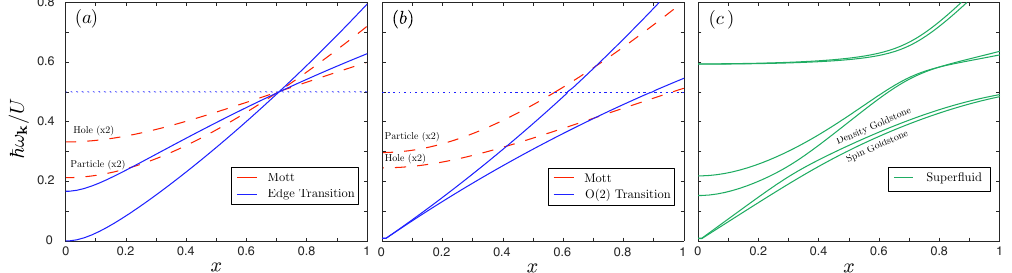
Figure 2: Excitation spectra across the MI-to-SF second-order (a) edge transition at µ/ U = 1 and (b) O ( 2 ) transition at ( µ/ U ) ≈ 0.914, as well as (c) in the superfluid c / U = 0.5 at fixed n = 2 in d = 2. For the phase for µ/ U = ( µ/ U ) , choosing U c 12 0, d edge transition in panel (a), the chosen hopping energies are 2 d J / U = 0.12 (red ≈ 0.167 (blue lines); for the O ( 2 ) transition in panel (b), the lines) and 2 d ( J / U ) c ≈ 0.172 (blue lines) hopping energies 2 d J / U = 0.12 (red lines) and 2 d ( J / U ) max c are considered. The hopping energy in the SF phase in panel (c) is 2 d J / U = 0.18. The parentheses in panels (a)-(b) refer to the degeneracy of the hybridized particle and hole bands, while the spin and density Goldstone modes are indicated explicitly. The blue dotted horizontal lines correspond to the doubly degenerate non-dispersive band ω 0,2